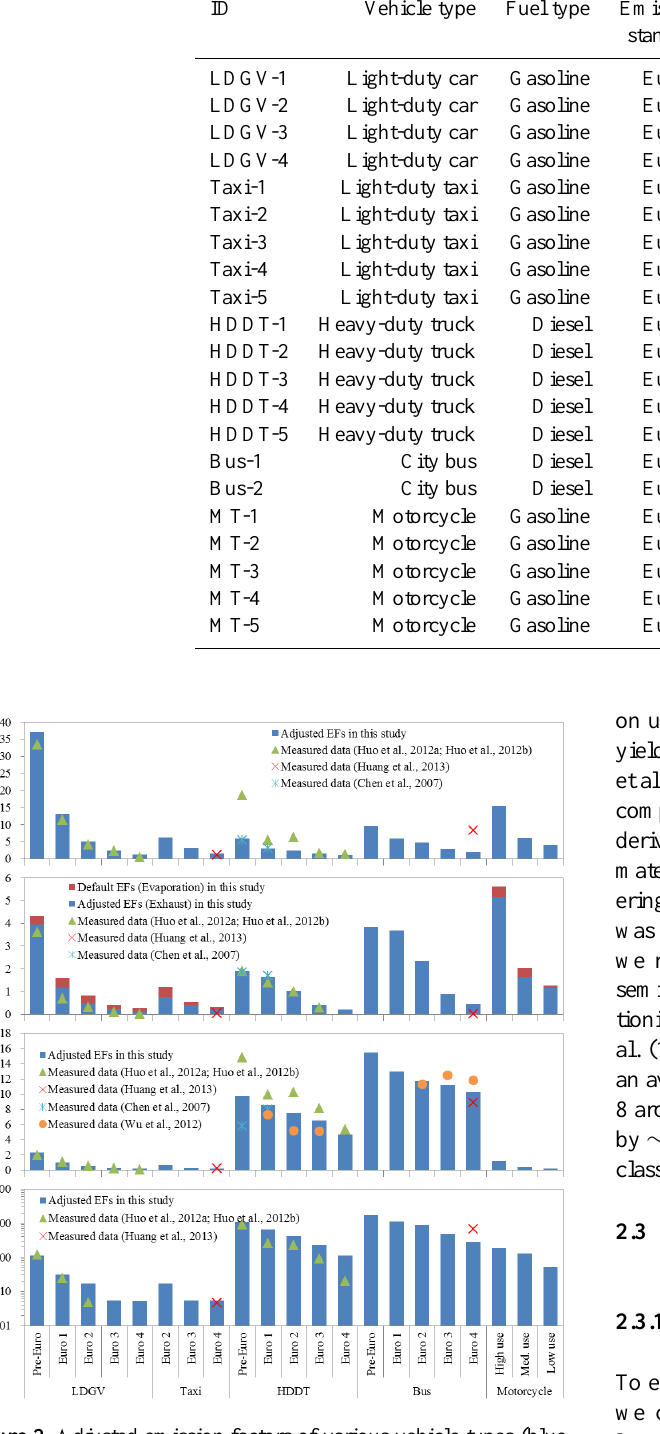
Figure 2. Adjusted emission factors of various vehicle types (blue bars) and their comparisons with measured emission factors in the previous studies